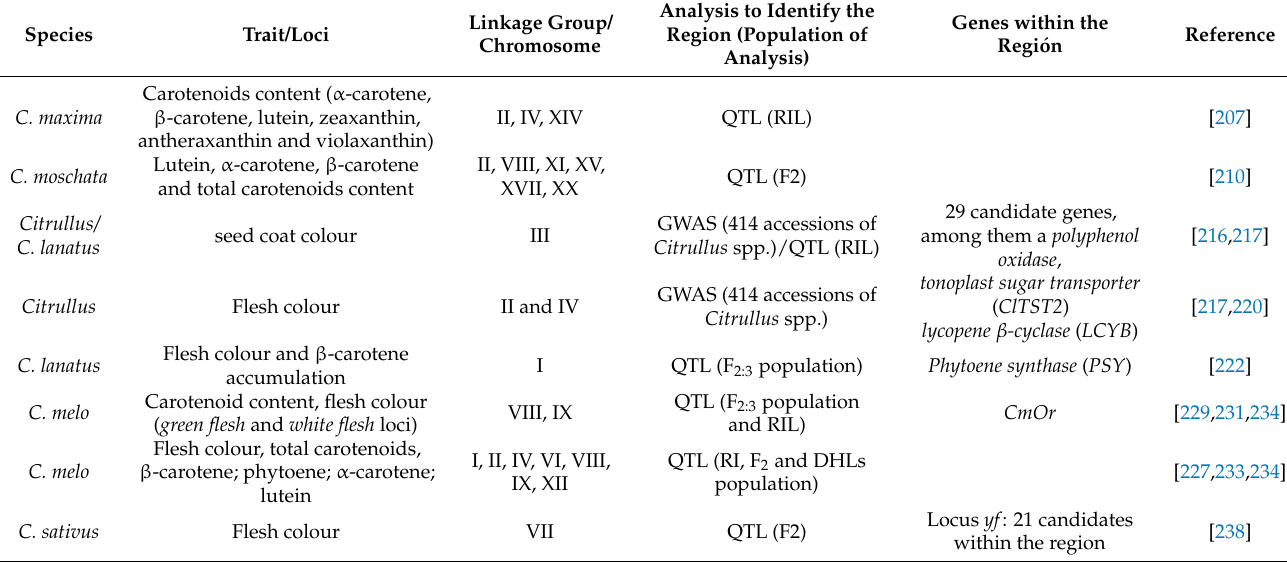
Table 2. Identification of QTLs and genes controlling the production of antioxidant compounds in cucurbit species. Species Trait/Loci